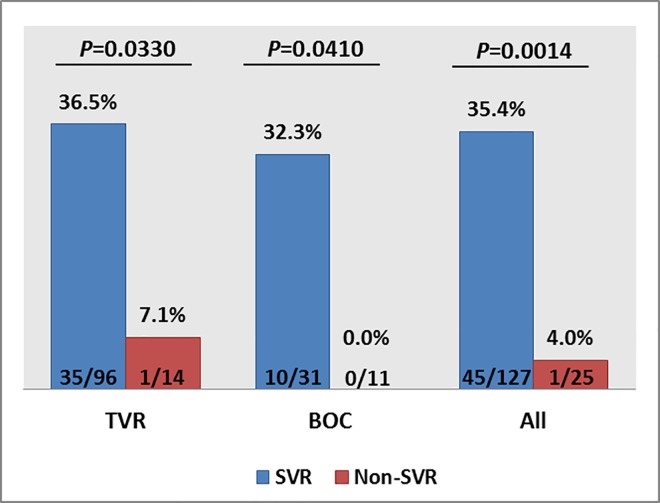
Frequencies of the rs12979860 CC genotype for PI therapies and association with treatment outcome.